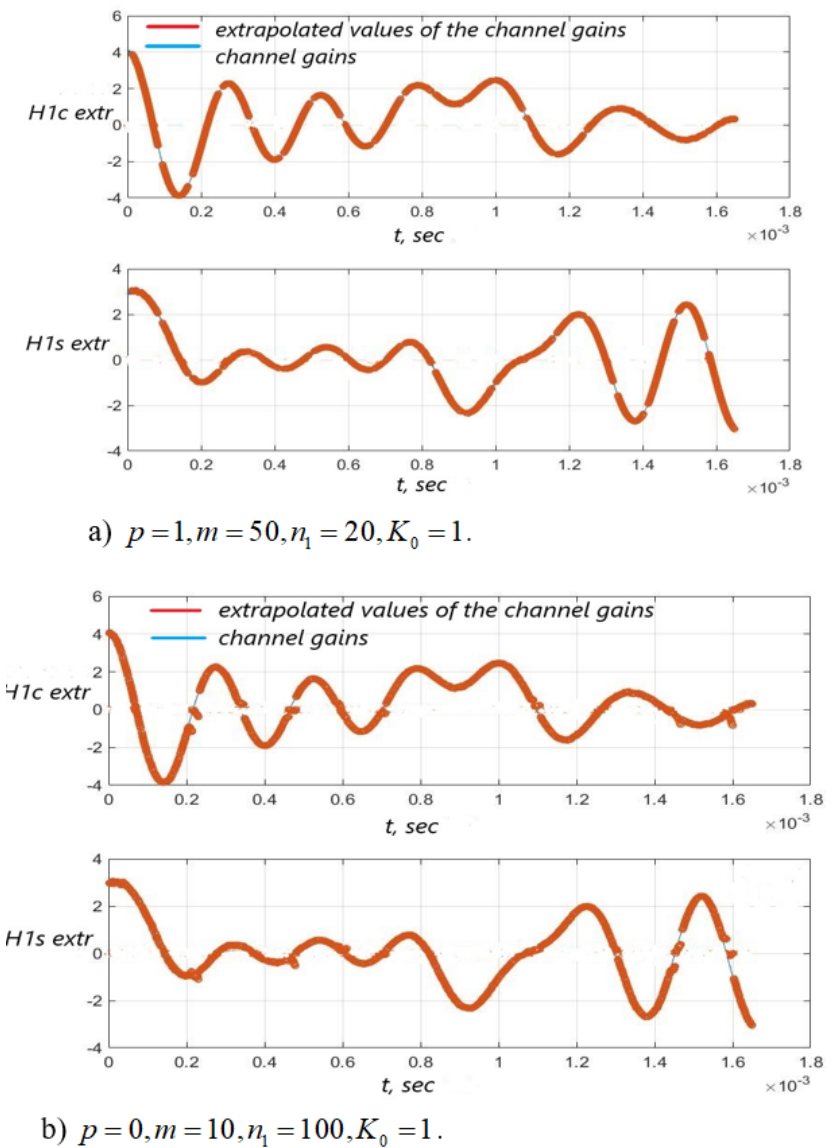
Figure 12. Extrapolated values of the channel gains H 1 c ( i ) , H 1 s ( i ) versus time for ( F + ∆ f ) T = 1.045 × 10 − 3 and p = 1—( a ), p = 0—( b ), SNR = 26 D